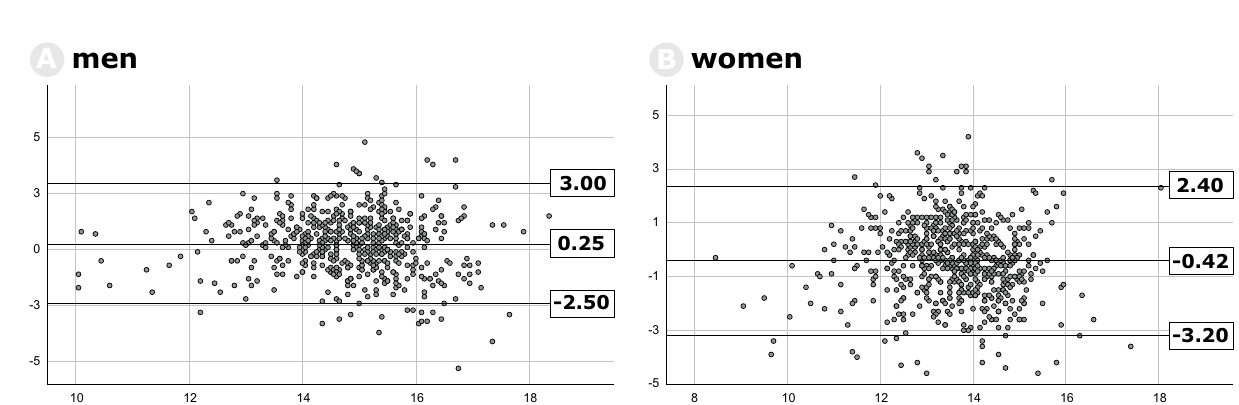
Figure 3. Bland–Altman-Plot for LabHb and SpHb in ( A ) men and ( B ) women; x-axis denote average between two measurements, y-axis denote differences between two measurements, horizontal lines indicate mean differences and limits of agreement between two measurements (= mean deviation ± 2 × standard deviation),